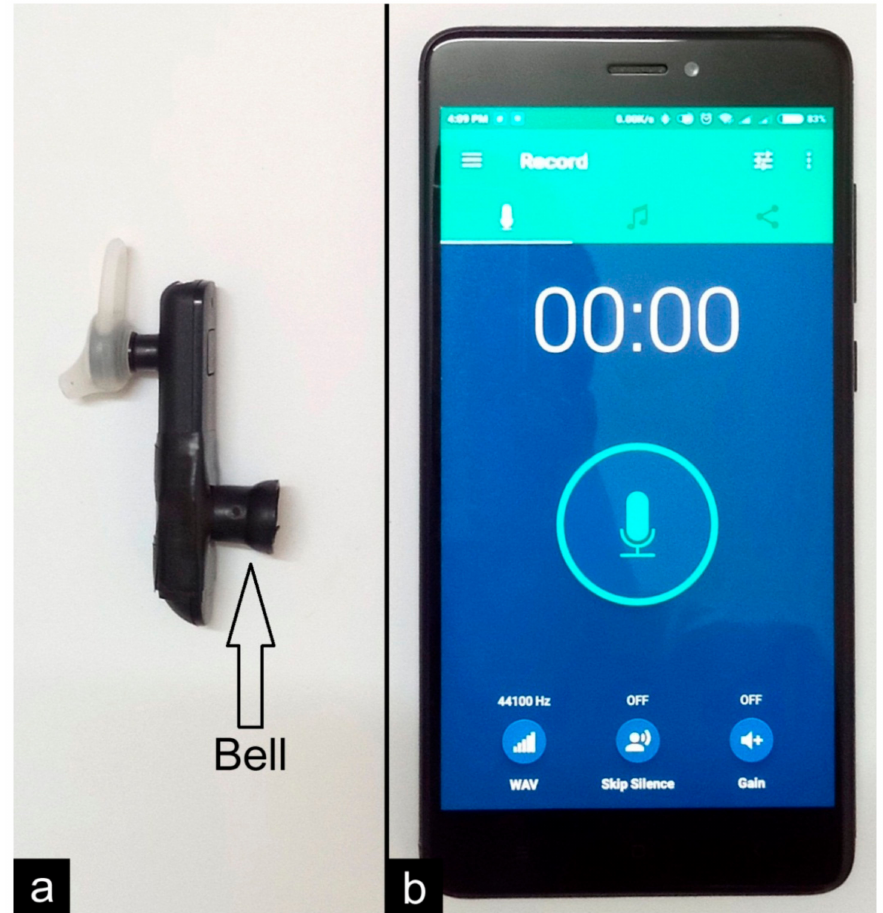
Figure 4. Developed wireless phonocardiograph (WiPCGh). ( a ) Modified Bluetooth headset; ( b ) mobile phone with audio recording software (Parrot user